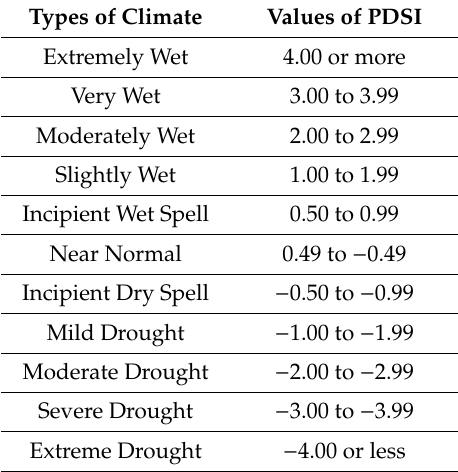
Table 2. The Palmer Drought Severity Index (PDSI) climate